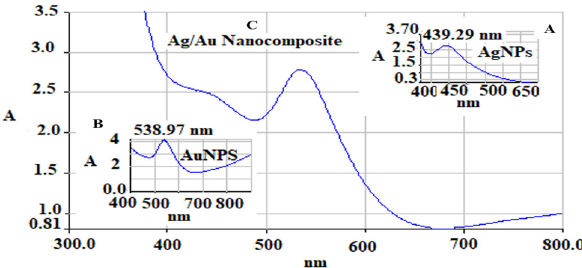
Figure 2: UV - Vis spectra of the composite nanoparticles using the argel